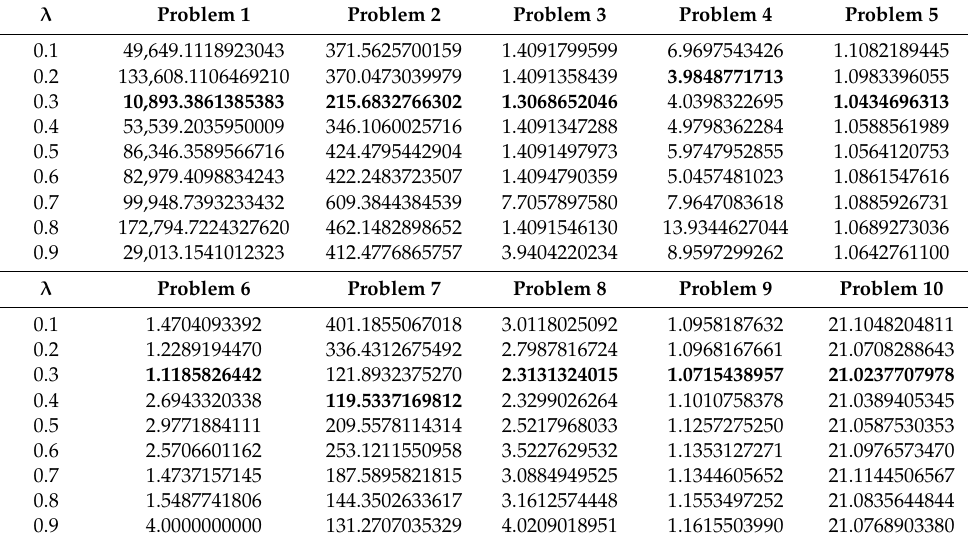
Table 4. The di ff erent subpopulations in the AKQPSO